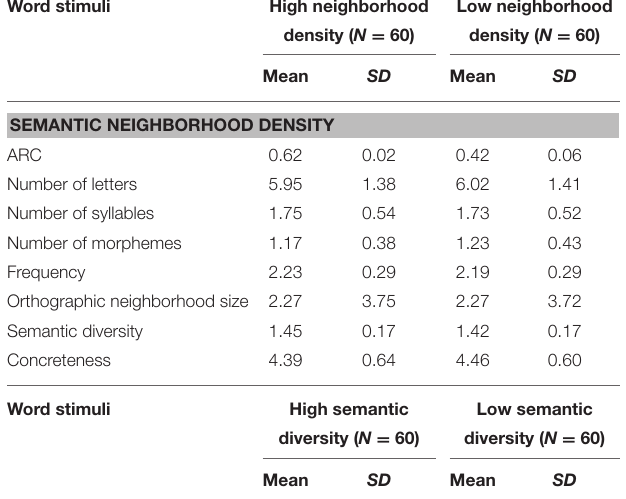
TABLE 5 | Descriptive statistics for the noun stimuli used in Experiment 2. TABLE 6 | Mean RTs and accuracy rates as a function of semantic neighborhood density/semantic diversity and stimulus